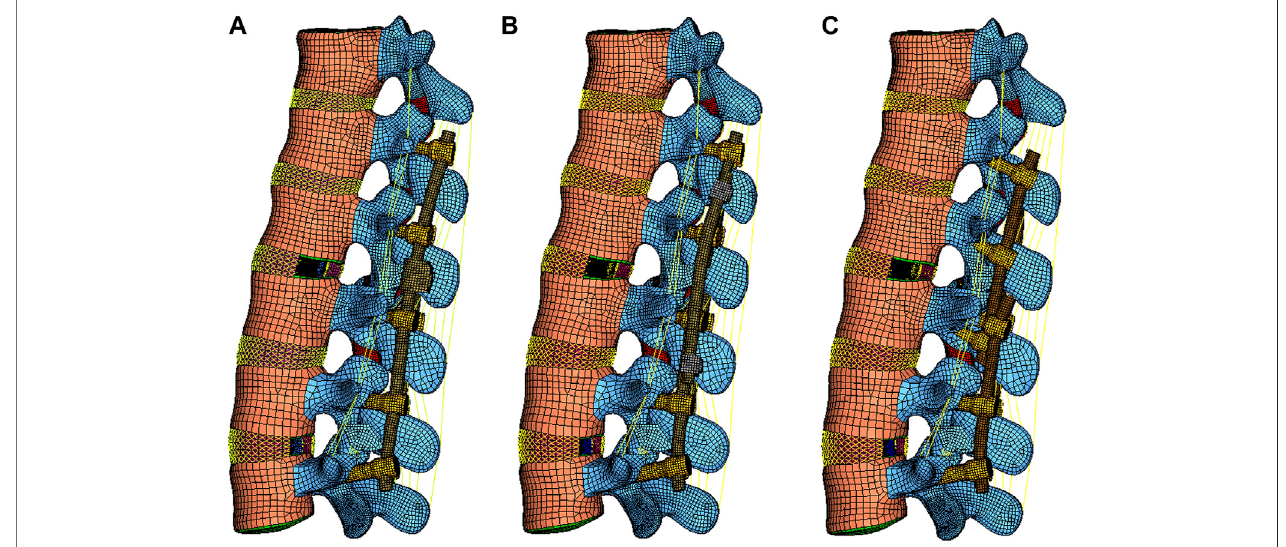
FIGURE 2 | Lateral views of the RS FE model constructed using the DRCm (A) , SRC (B) , and CBTC (C) .